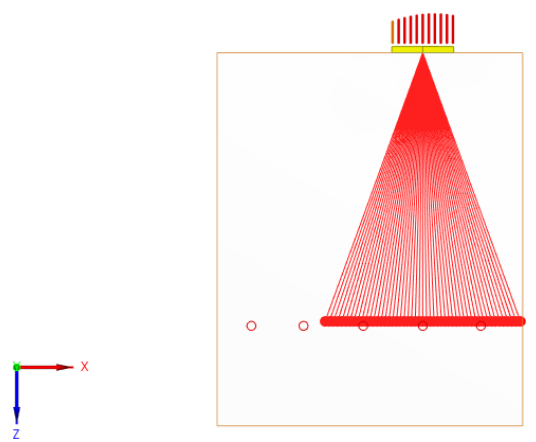
Figure 16. Representation of the sectorial scanning configuration for the inspection of the side-drilled holes.